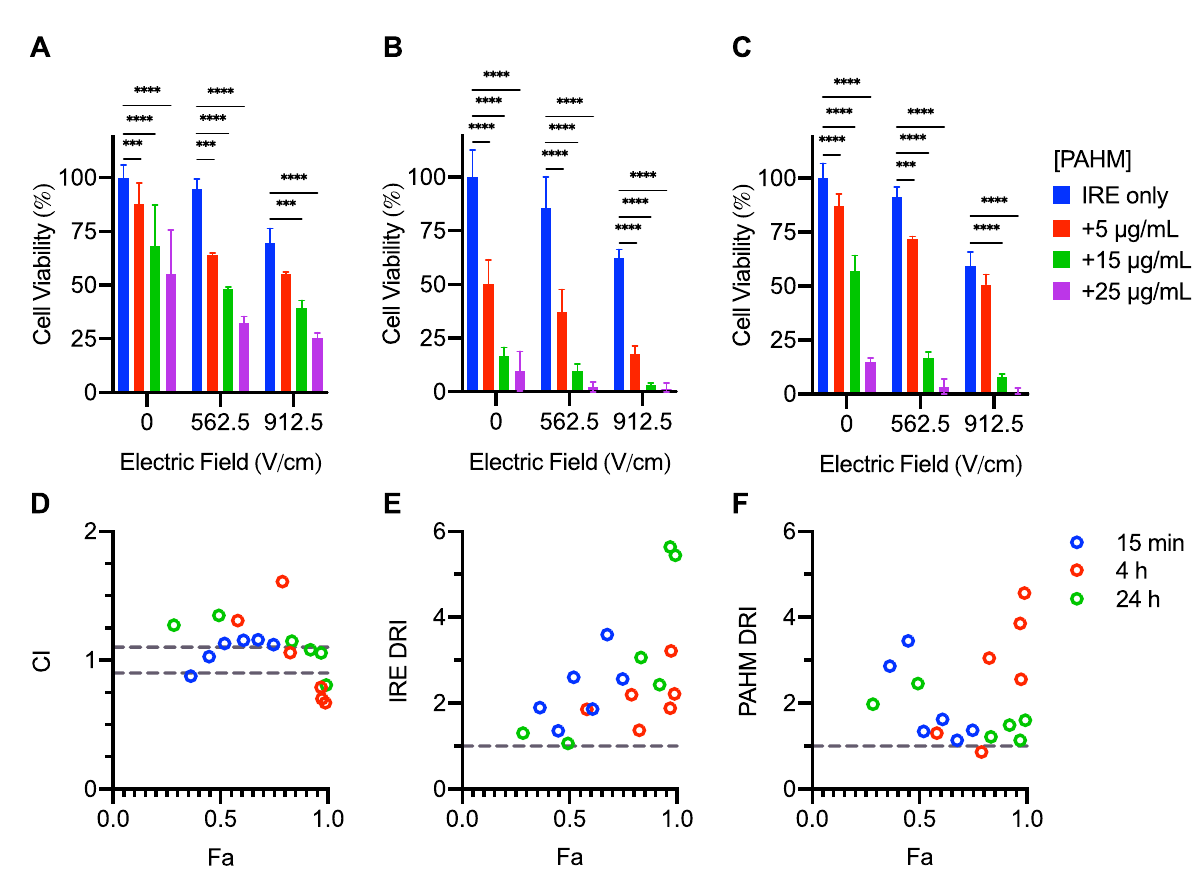
Figure 3. Cell viability after IRE treatment combined with PAHM exposure for ( A ) 15 min ( B ) 4 h ( C ) 24 h. Data are shown as mean ± SD (n = 3–12). ANOVA with Tukey HSD test (*p < 0.05, **p < 0.01, ***p < 0.001, ****p < 0.0001). ( D ) Combination index analysis (CI < 1, = 0.9–1 (dashed lines), > 1 indicates synergism, nearly additive effect, and antagonism, respectively). Dose reduction index analysis for ( E ) IRE and ( F ) PAHM (DRI < 1, = 1 (dashed line), > 1 indicates unfavorable dose reduction, no dose reduction, favorable dose reduction,